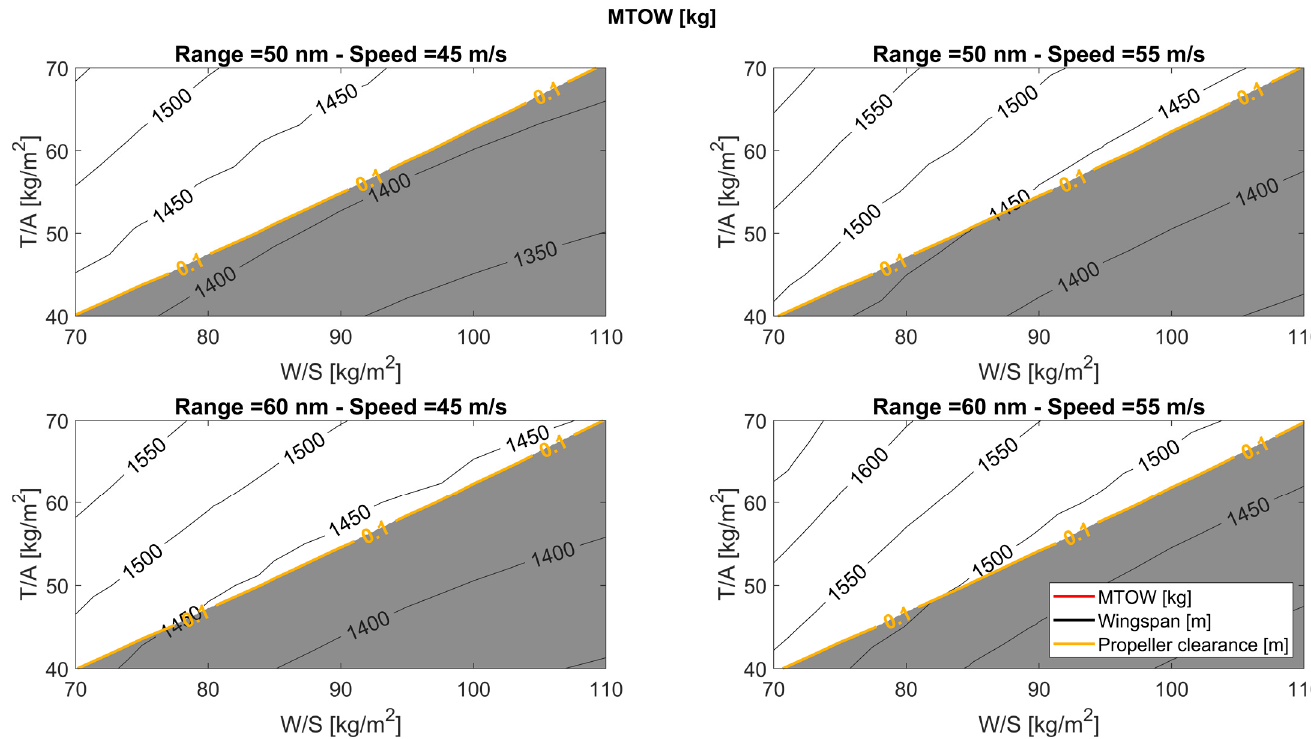
Figure 15. W/S vs. T/A charts of MTOW (future technology) varying speed and range. Each plot shows a highlighted area, which identifies the design space compliant with the constraints.